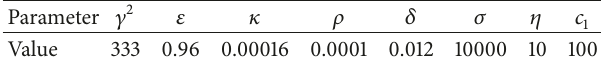
Table 3: Control